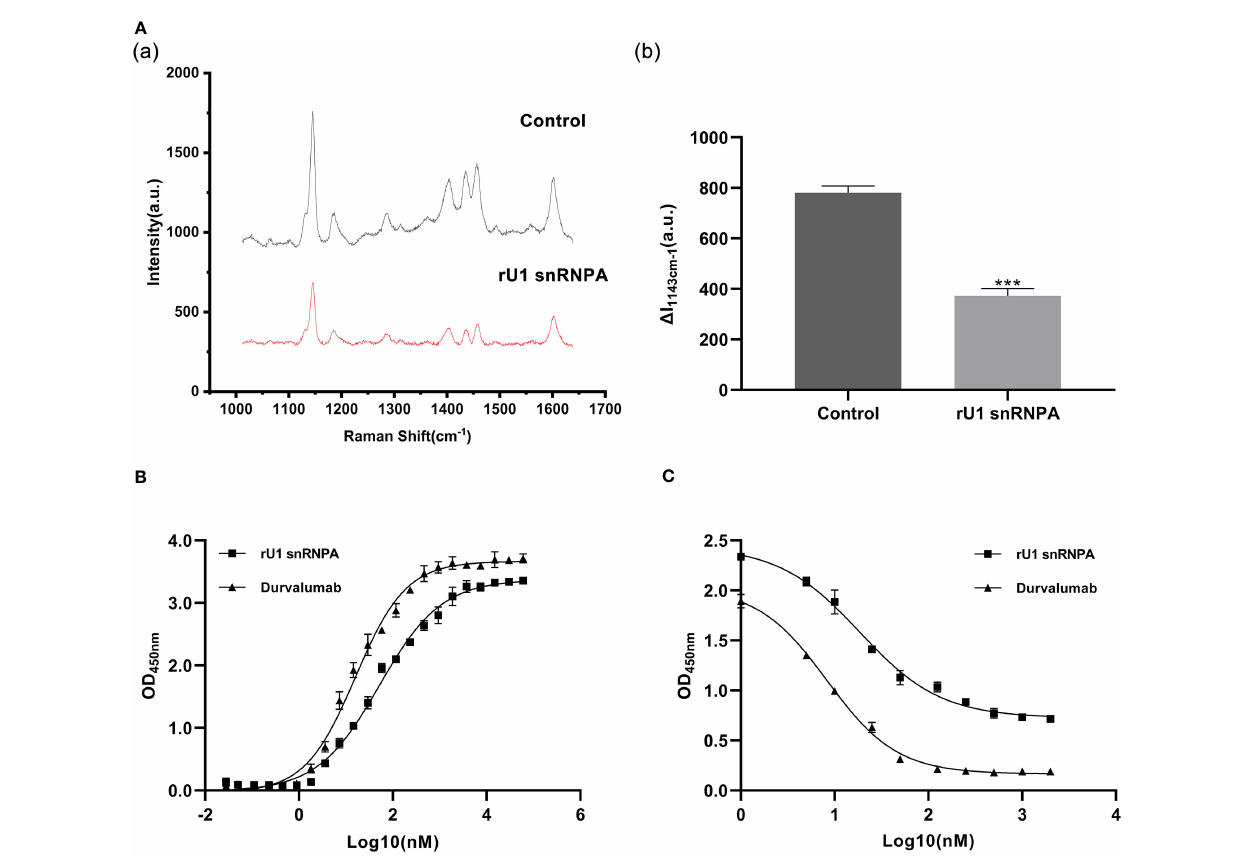
FIGURE 2 | Results of binding ability to PD-L1 and inhibition effect on PD-1/PD-L1 interaction. (A) Comparison of SERS spectra of rU1 snRNPA (1.5 m M) and control. (a) Representative SERS spectra. l ex = 632.8 nm, t = 5 s, and accumulation times = 1. (b) Intensity of the characteristic peak of 4-amnobiphenyl with the results of three repeated experiments. Data are shown as mean ± SD. *** P < 0.001. (B) Binding curves of rU1 snRNPA and durvalumab. Curve fi tting was performed by using GraphPad Prism 8.0. Error bars denote SD. The experiment was performed in double for each sample group. (C) Inhibition curves of rU1 snRNPA and durvalumab. Curve fi tting was performed by using GraphPad Prism 8.0. Error bars denote SD. The experiment was performed in double for each sample